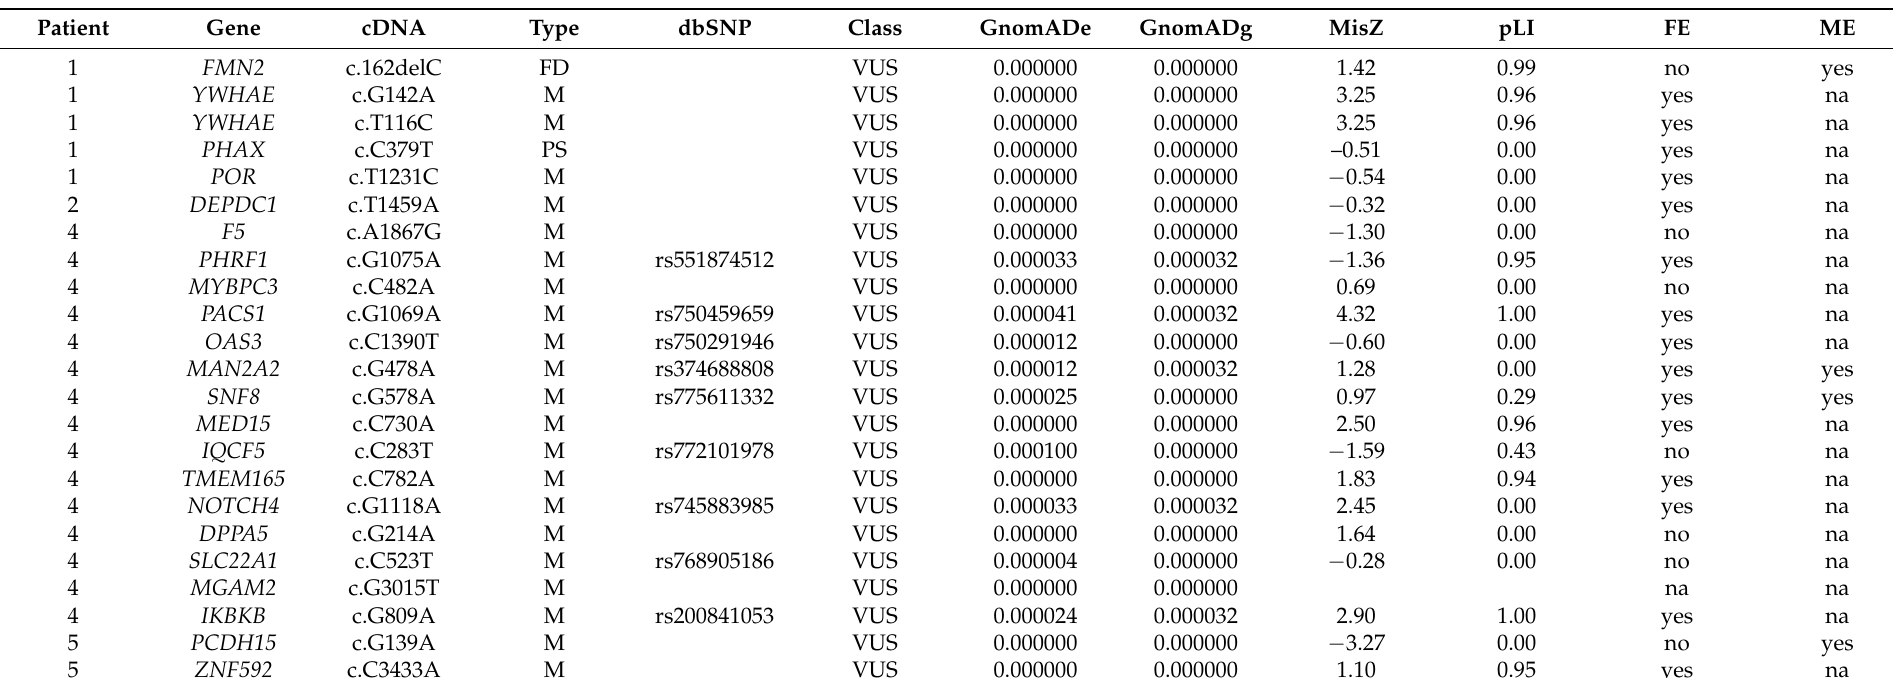
Table 2. Variants identified in DNA isolated from ENCCs of each patient, passing quality criteria and prioritization based on predicted deleteriousness, expression pattern and sensitivity for a gene to rare variation (conserved coding